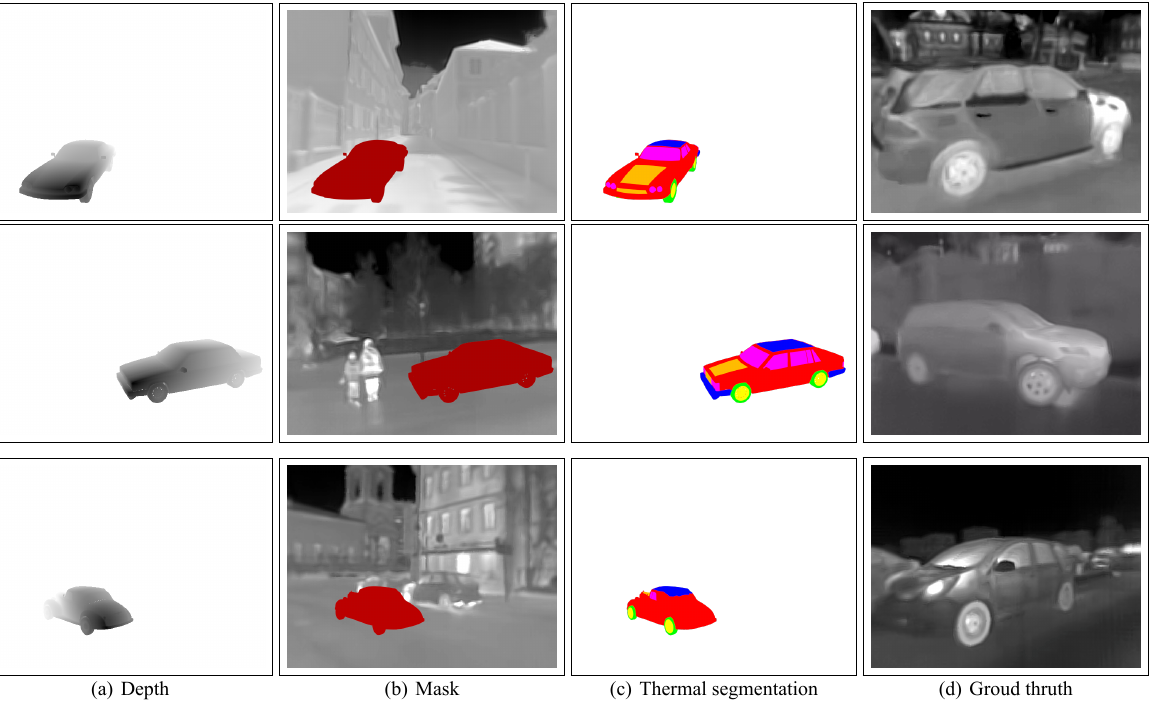
Figure 5. Examples of input images dataset